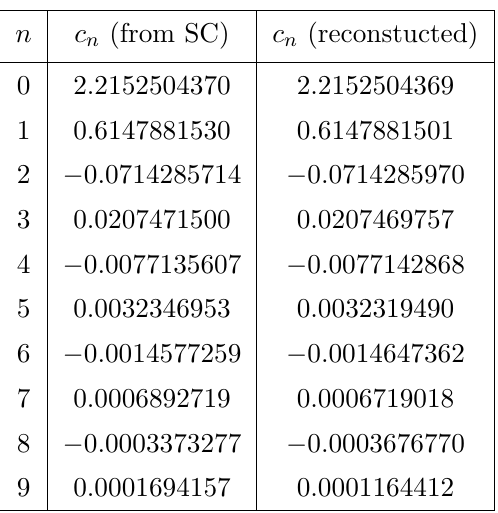
Table 2. Comparison between the N 2 = 10 calculated coefficients c n of the expansion of f 2 ( z ) around z 2 . The two columns show the analytically obtained values from the spectral curve (SC) and the reconstructed values using the Darboux